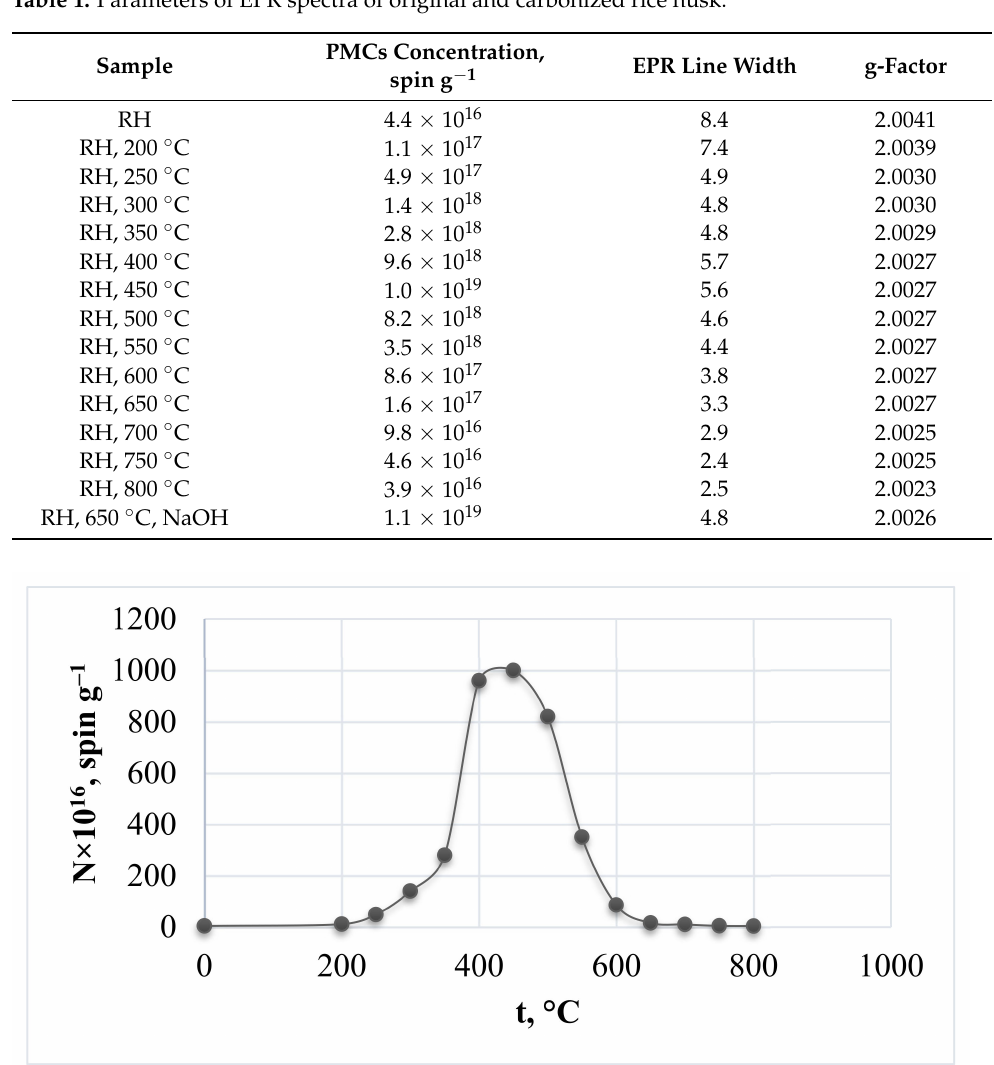
Figure 7. Dependence of the concentration of paramagnetic centers on the carbonization temperature of rice